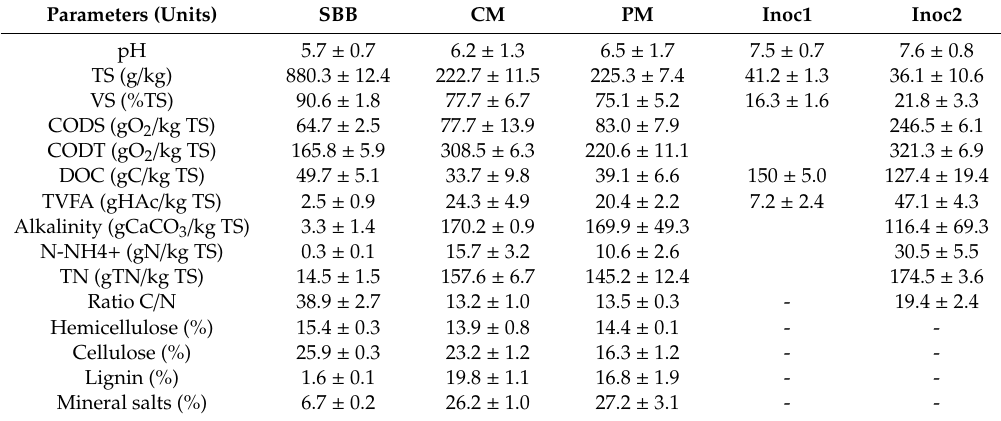
Table 1. Physicochemical properties of sugar beet by-products (Sugar beet by-products, cow manue, pig manure), and